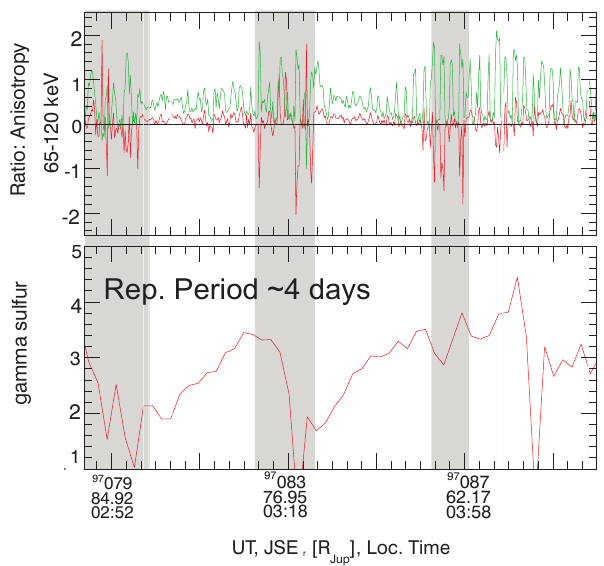
Fig. 2. First order anisotropies in the radial (red, positive is out- ward) and corotational direction (green) (top); the sulfur energy spectral index γ , averaged over 10-h-averages (bottom). The time interval DOY 078, 00:00UT to DOY 090, 00:00UT in 1997 (or- bit E6) is shown. Grey shadowed areas indicate times at which the Jovian magnetotail is in a “disturbed” state. A “disturbed” state is usually associated with the ion flow bursts, i.e. deviations of the plasma flow from the corotational (the red component is higher than